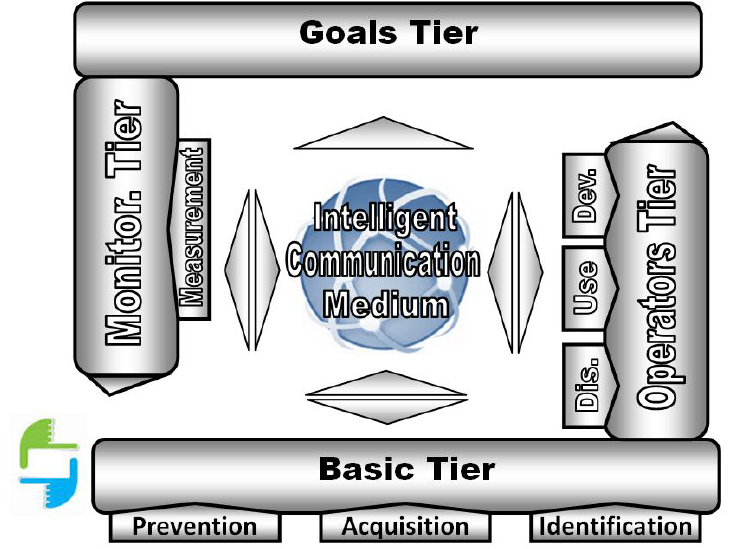
Fig. 1. New conceptual model for KM implementation in HBs-related project organizations, hereafter named as Finger Frame Model